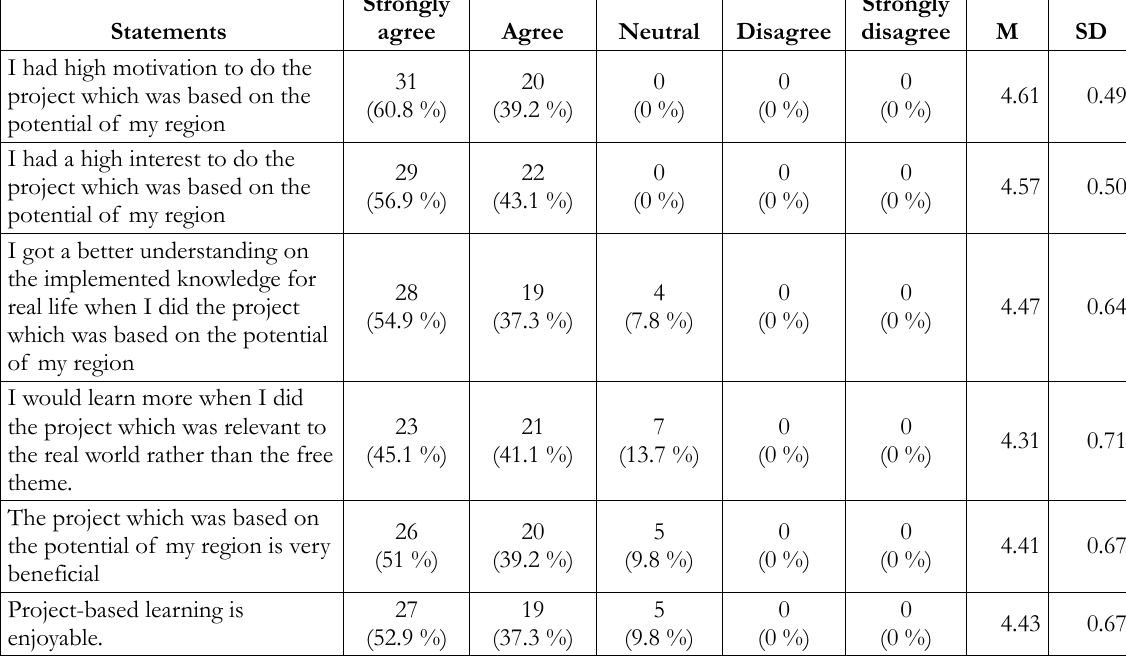
Table 3. The data analysis of students’